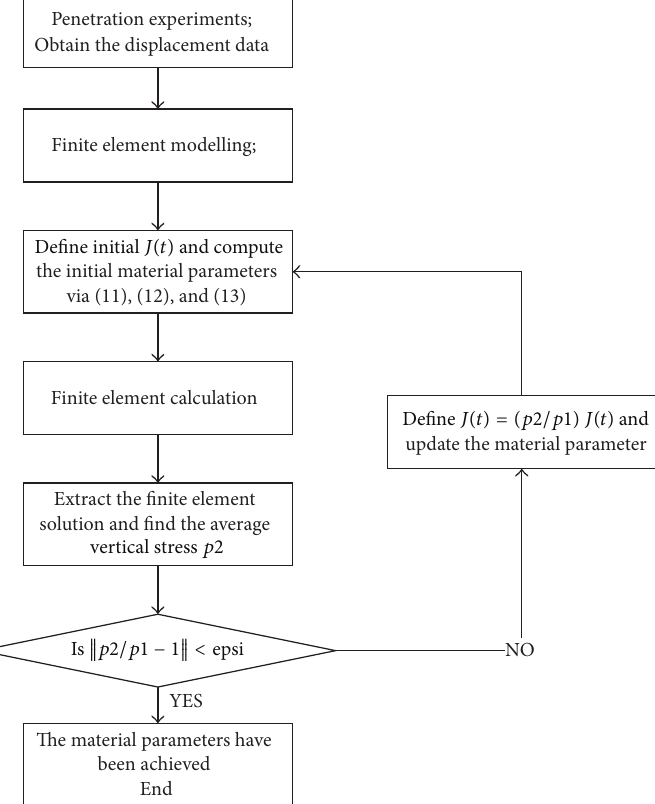
Figure 11: Flow chart of stress-correction